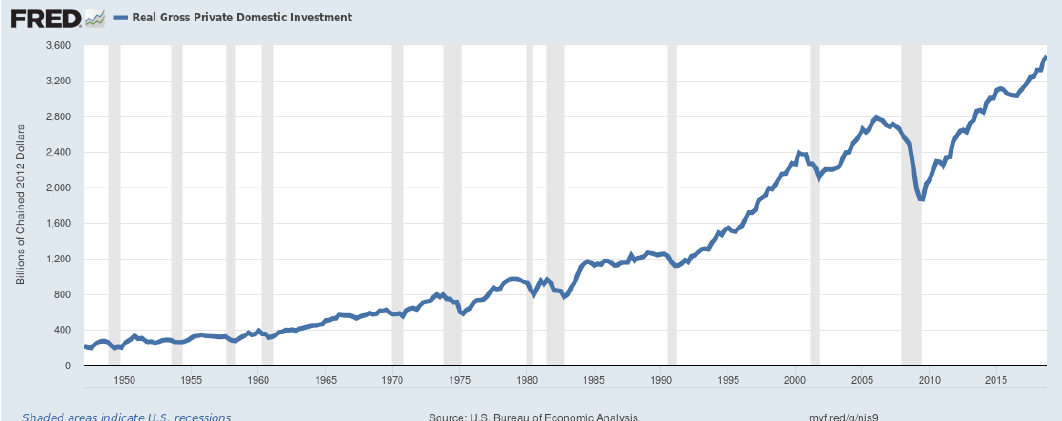
Figure 4. USA real gross private domestic investment ( GPDIC1 ), billions of chained 2012 dollars, seasonally adjusted annual rate. Source: FRED, Federal Reserve Bank of St. Louis; https://fred. stlouisfed.org/series/GPDIC1, 16 March 2019. Greyed areas correspond to periods of economic recessions (Table